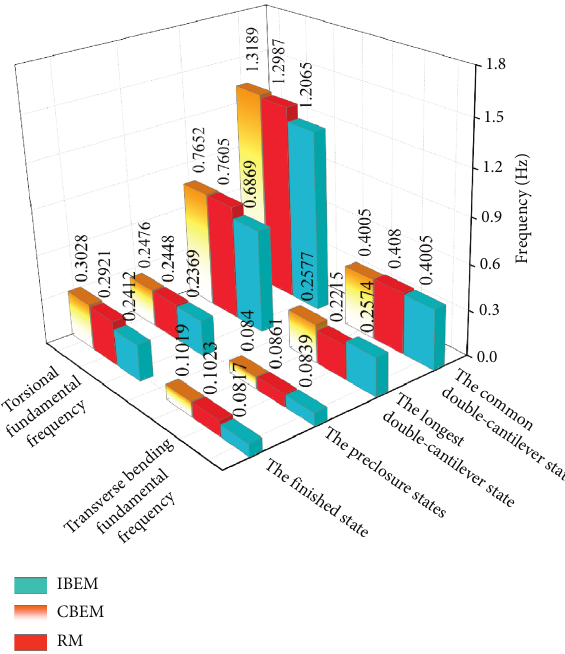
Figure 9: Fundamental frequency comparison in different stages. Table 3: Correction parameters in different states.